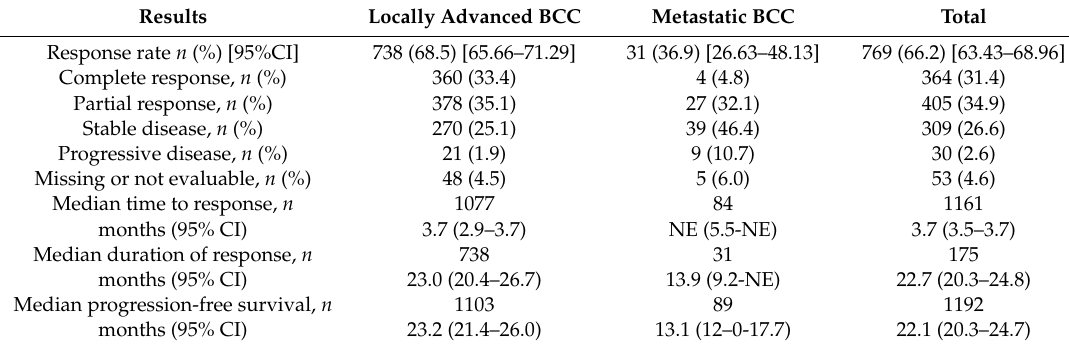
Table 2. E ffi cacy of Vismodegib in STEVIE